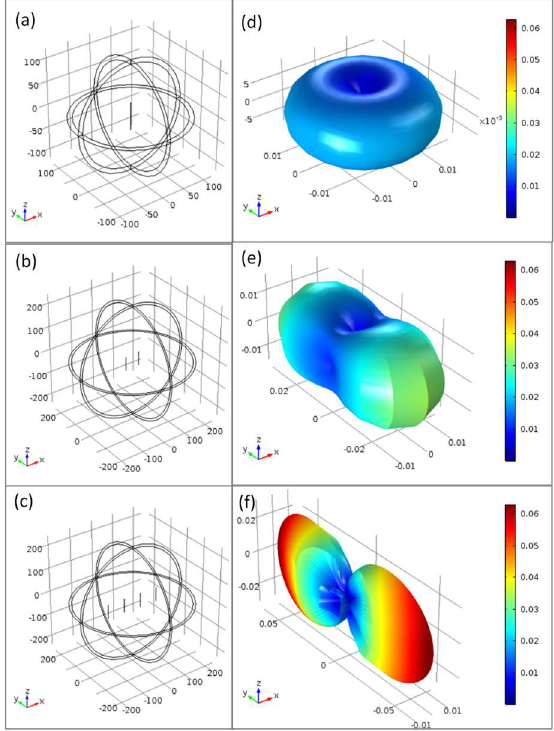
Figure 4. ( a – c ): One, two and four-element arrays of half-wave dipole antenna respectively separated λ / 2. ( d – f ): COMSOL simulations of radiation field patterns of each array having a half-wavelength spacing between dipoles with I = 0.4 mA.